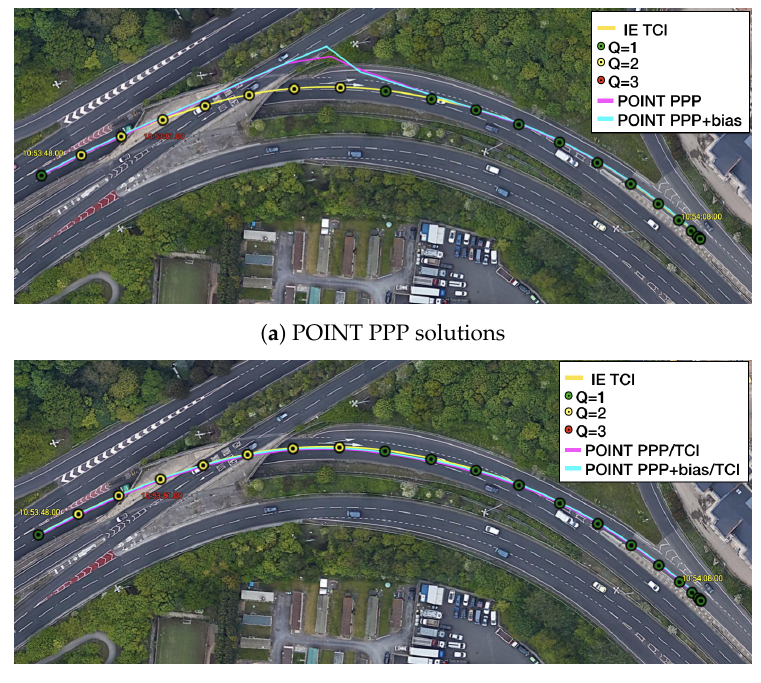
Figure 18. Re-convergence example 1 on Google Earth. The red epoch 10:53:51 signifies when the van entered a tunnel. IE stands for the reference software Inertial Explorer (The same below).